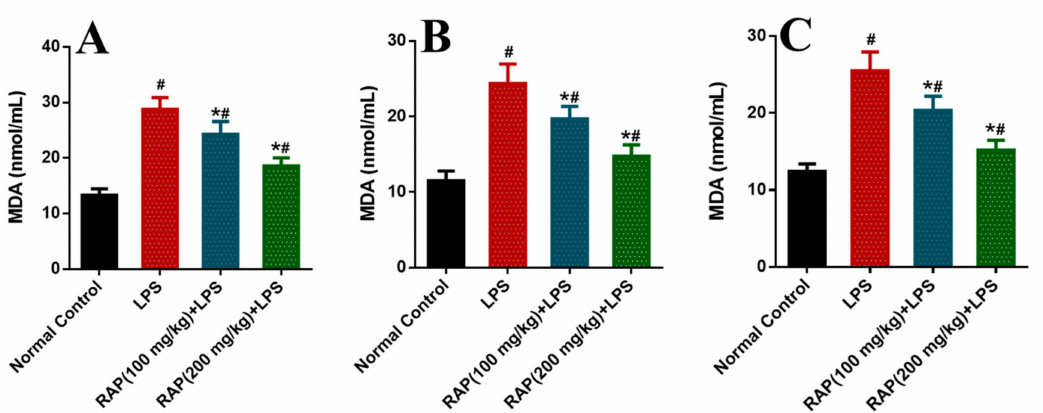
Figure 3. Determination of MDA in ( A ) plasma, ( B ) Liver and ( C ) Brain. Results are mean SEM of seven animals per group. ‘*’ denotes significant di ff erences compared with the normal control group ( p < 0.05); ‘#’ denotes significant di ff erences compared with the LPS group ( p < 0.05).